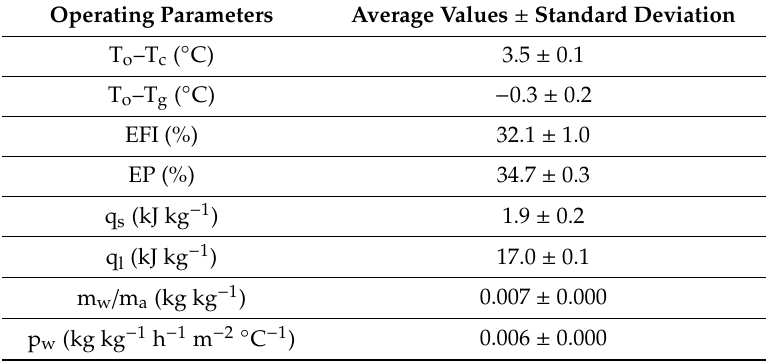
Table 2. The average values and standard deviation of the di ff erent operating parameters for the fan-pad system in test